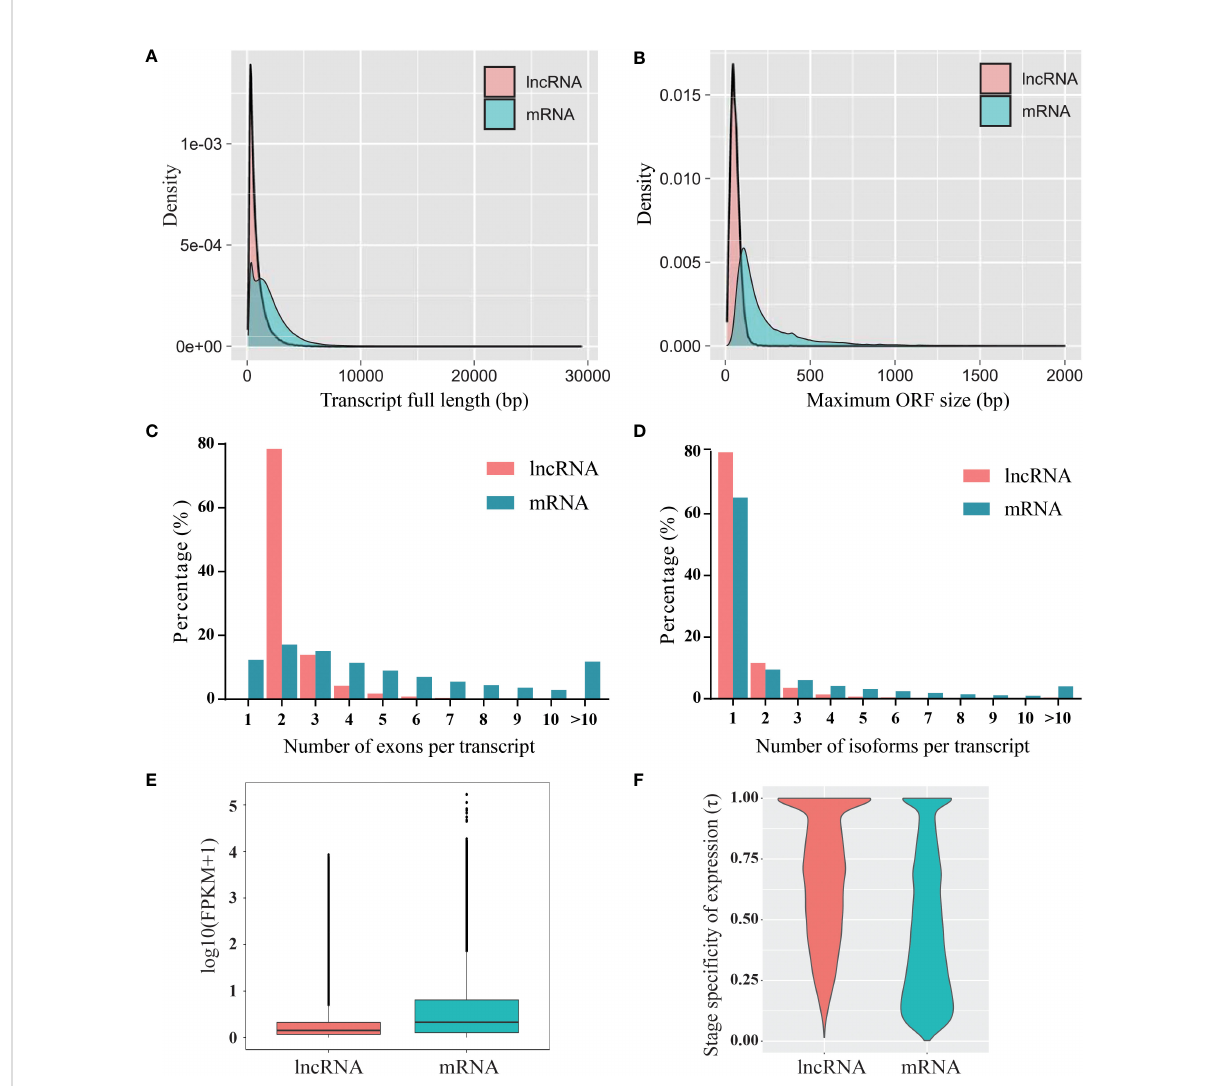
FIGURE 2 Characterization of blueberry lncRNAs compared to that of mRNAs. (A) Transcript length, (B) open reading frame (ORF) length, (C) exon number, (D) isoform number, (E) expression levels, and (F) expression speci fi